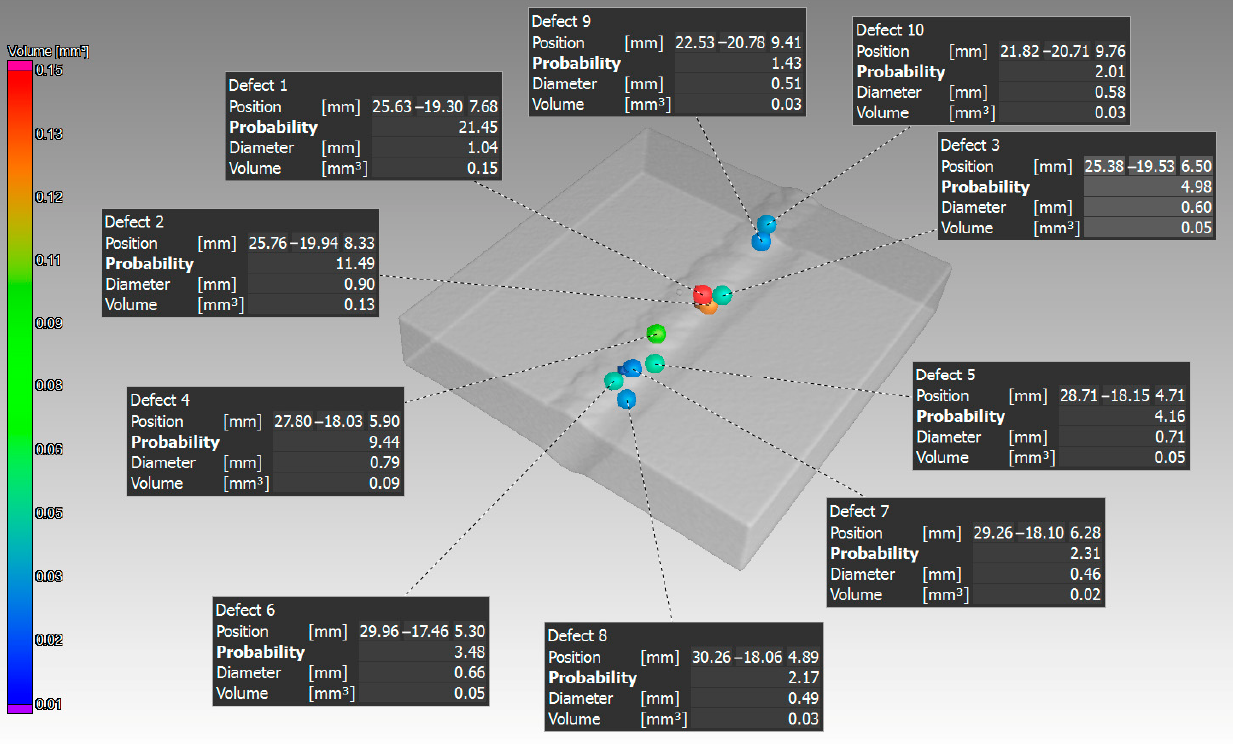
Figure 12. Computed tomography of weld joint no. 3 created without filler wire.